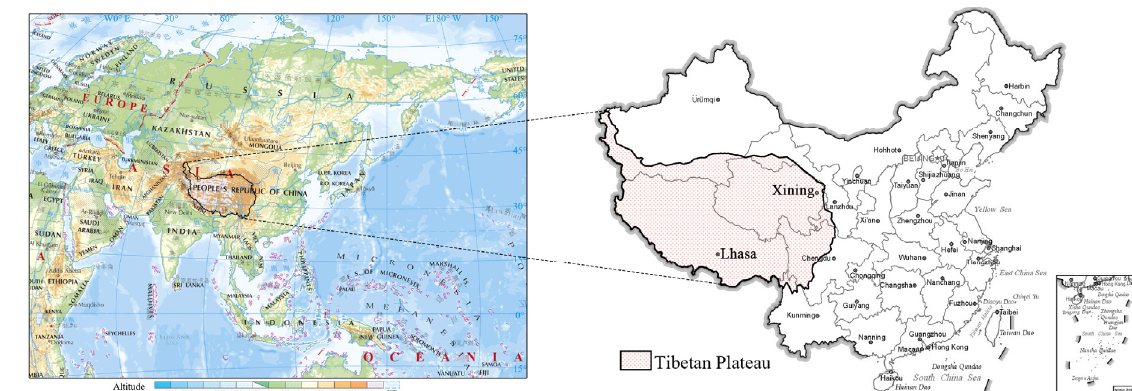
Figure 1. Location of the Tibetan Plateau.